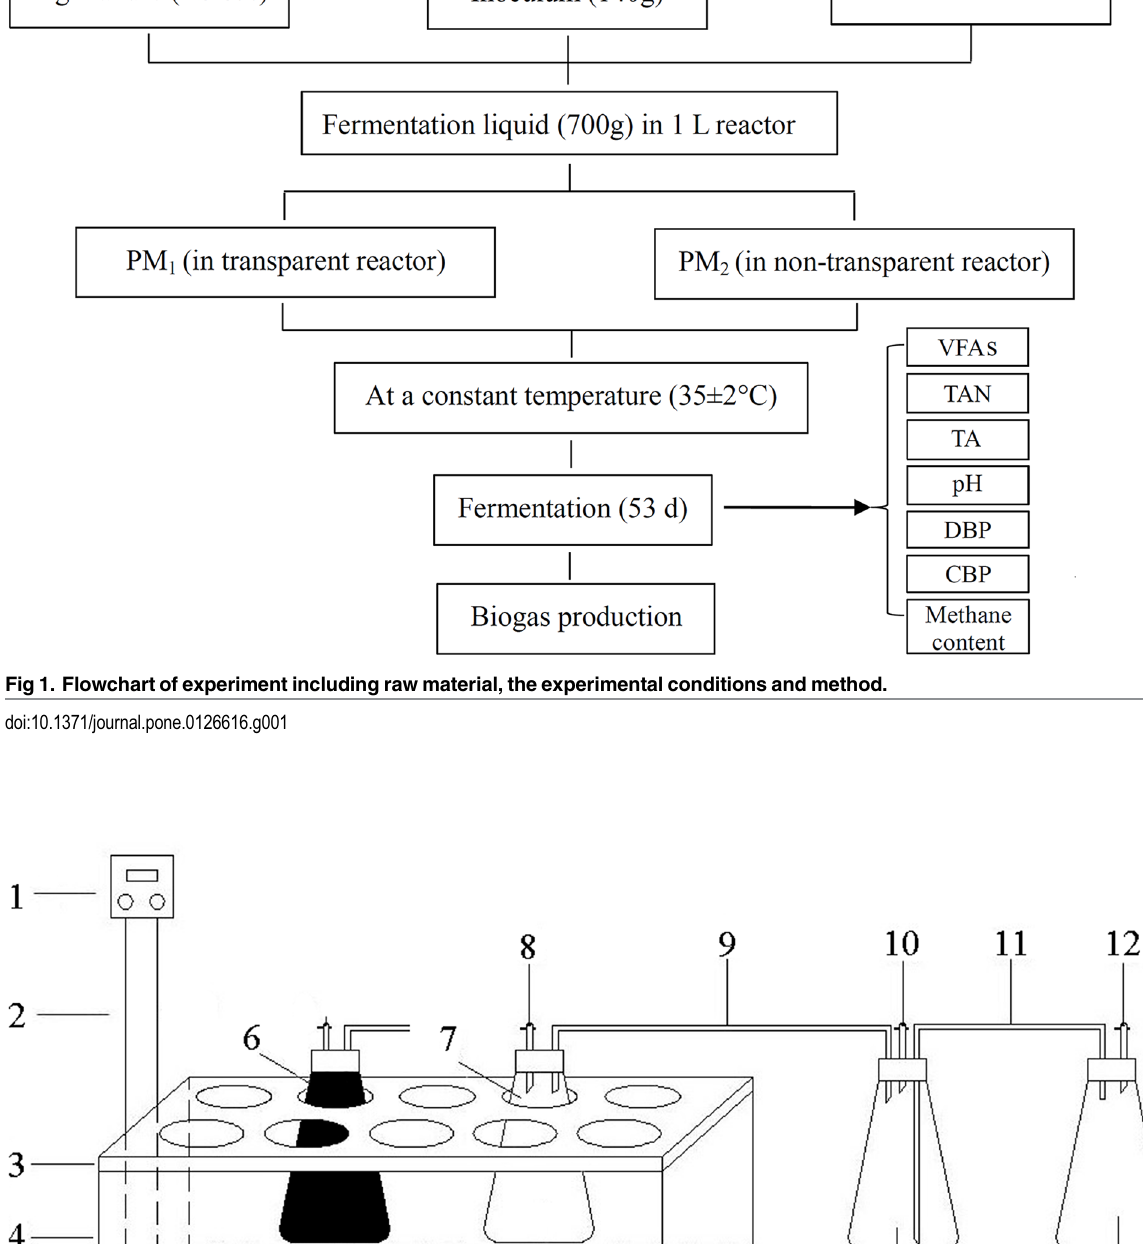
PLOS ONE | DOI:10.1371/journal.pone.0126616 May 13,